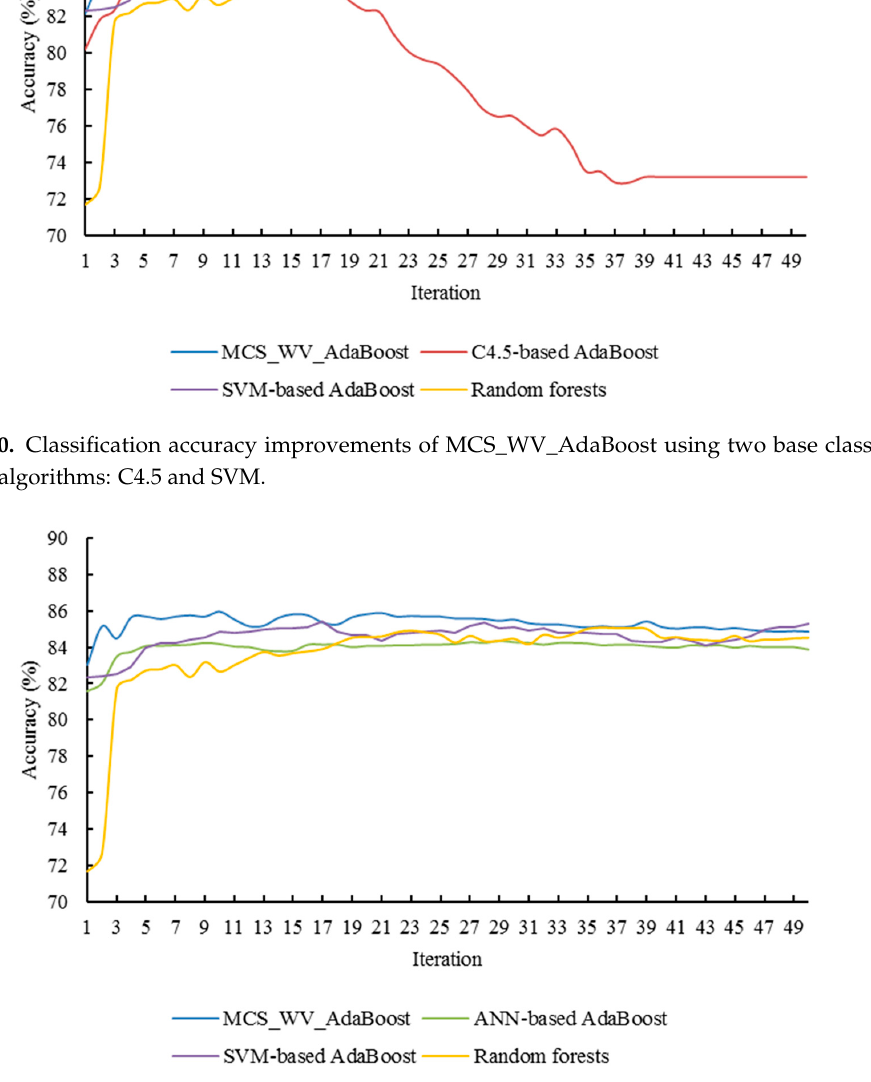
Figure 11. Classification accuracy improvements of MCS_WV_AdaBoost using two base classifier training algorithms: ANN and SVM.